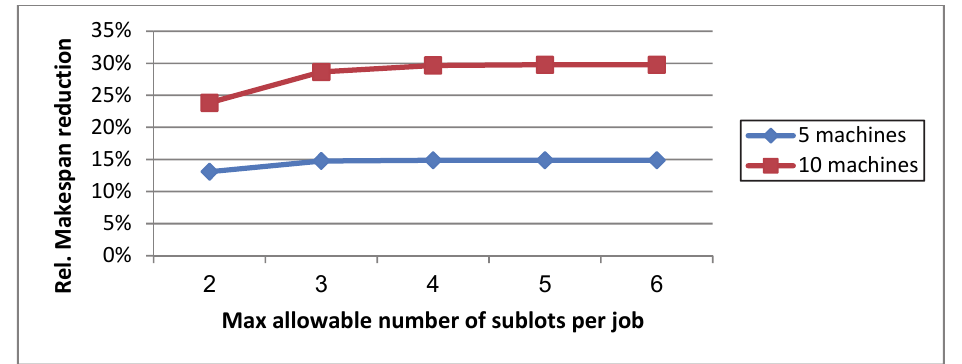
Fig 2. Makespan reduction with respect to the maximum allowable number of sublots per job, in